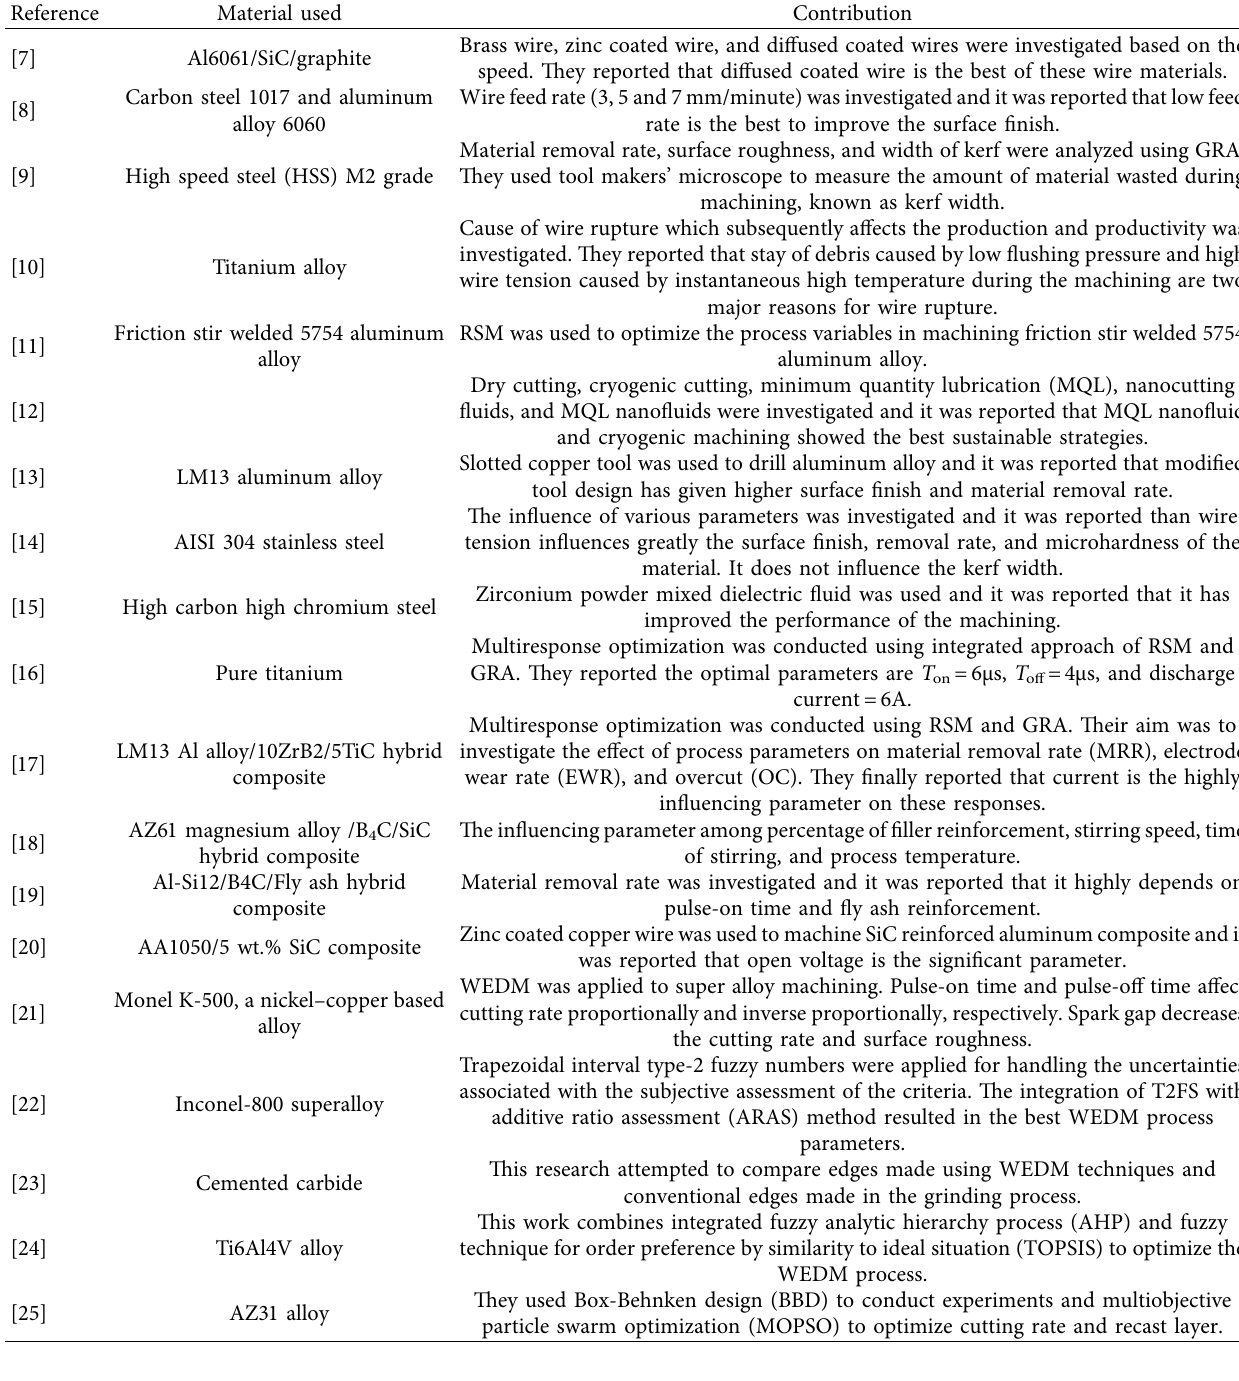
Table 1: Significant published articles on WEDM in recent